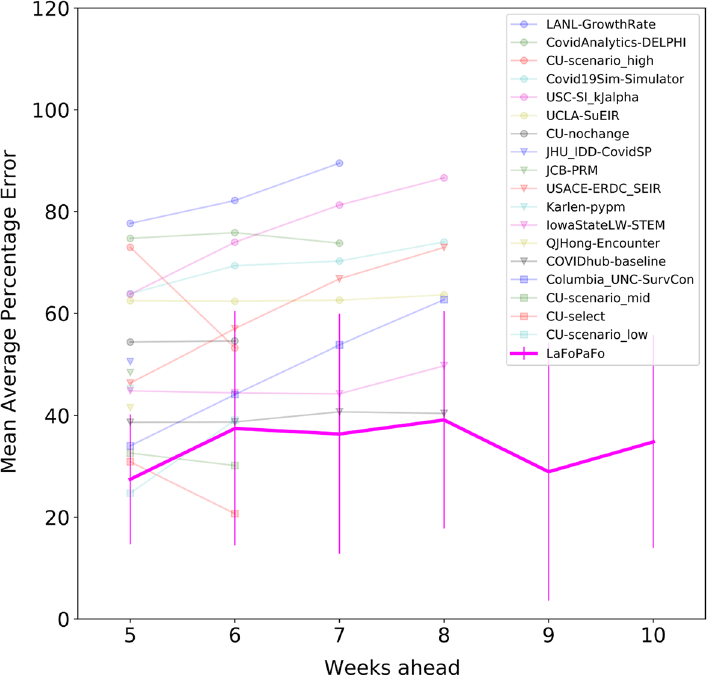
Figure 2. Forecast accuracy of the projected weekly number of reported COVID-19 cases in the US. The settings are the same as Fig. 1, but here the models are evaluated on forecasting the future number of reported COVID-19 cases. LaFoPaFo outperforms other models over almost every forecasting horizon. None of the CDC models provided forecasting results for future 9 and 10 week horizons.